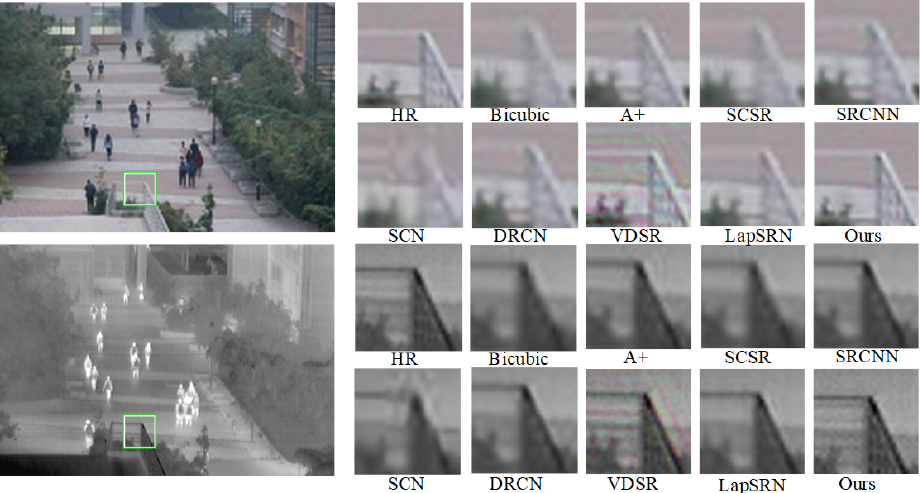
Figure 8. SR experiment results of scale 2 in Teaching building.